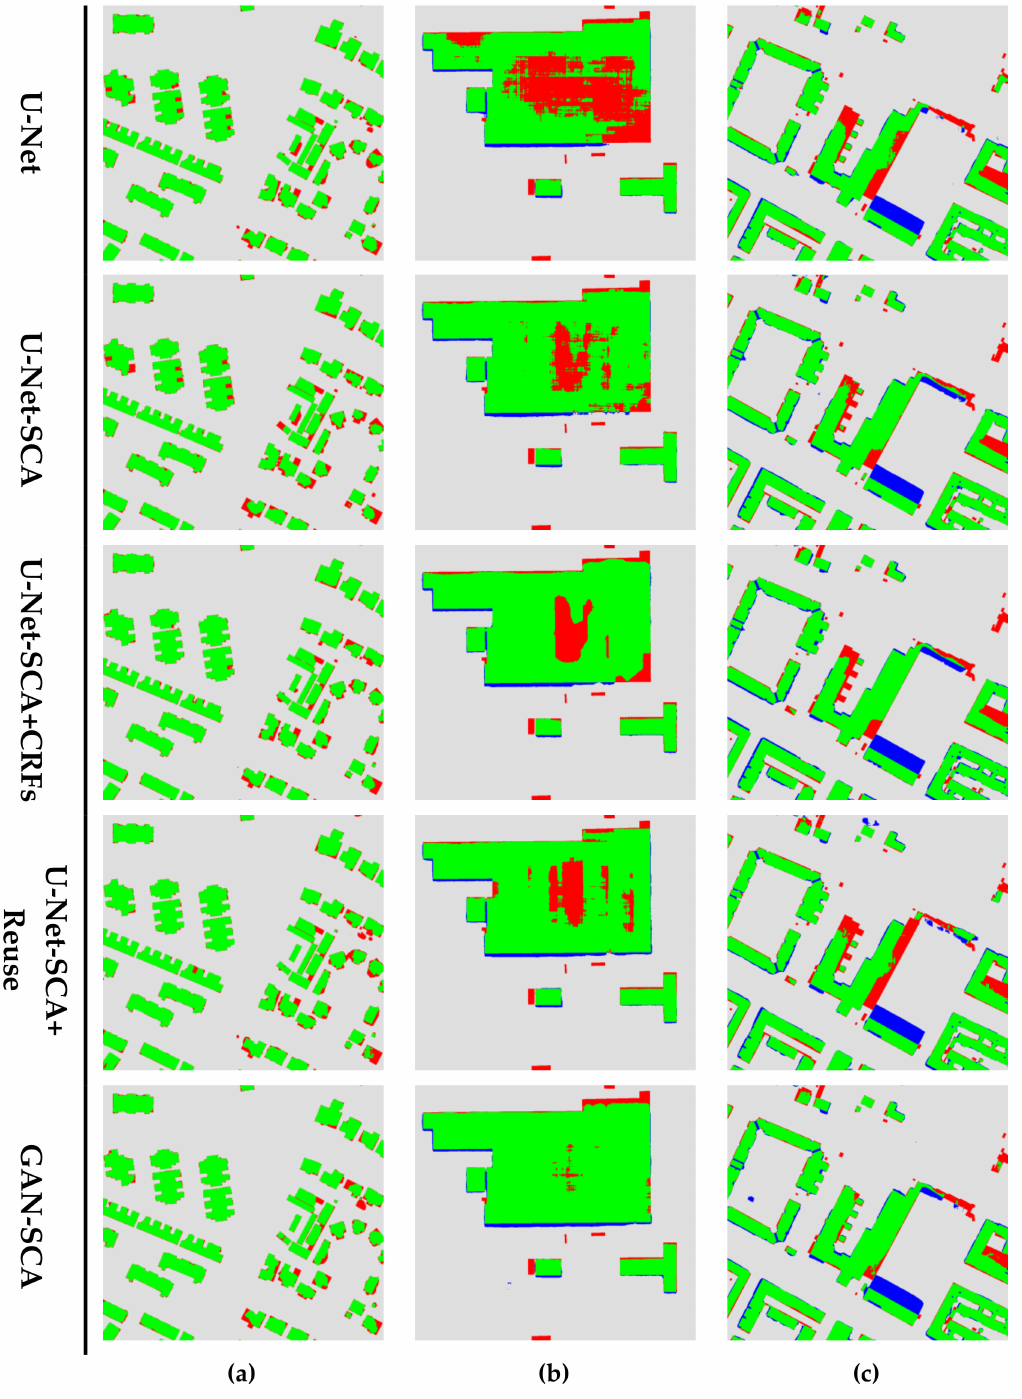
Figure 5. Building extraction results for three image patches of Inria aerial image labeling dataset. ( a ) Image patch over Austin; ( b ) Image patch over Chicago; ( c ) Image patch over Vienna. Green: true positive (tp) pixels; Gray: true negative (tn) pixels; Blue: false positive (fp) pixels; Red: false negative (fn)